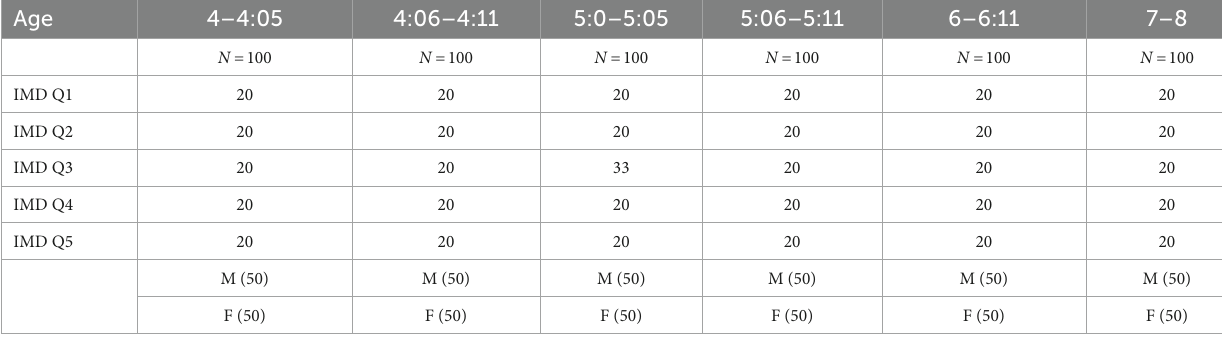
TABLE 1 Target stratified sampling